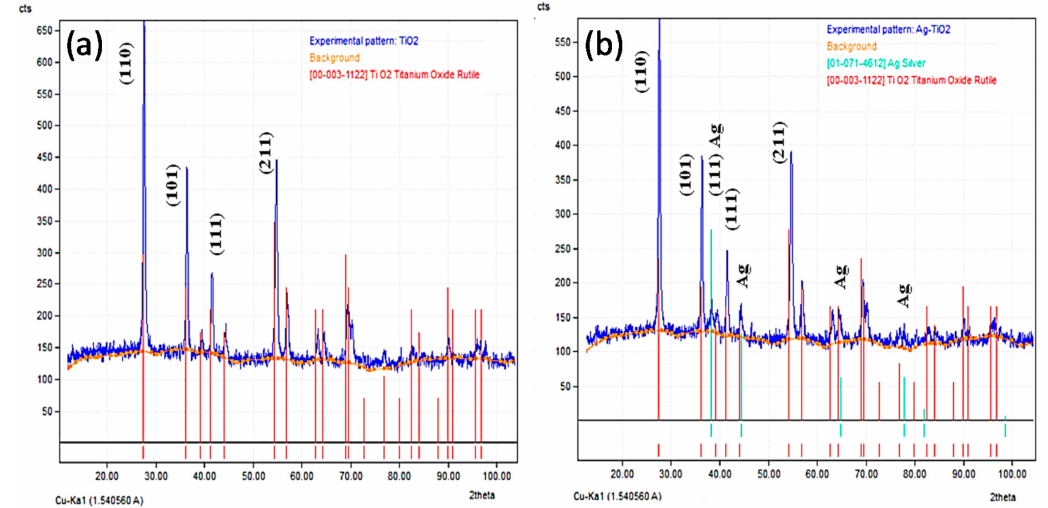
Figure 3. XRD patterns of ( a ) TiO 2 nanoparticles and ( b ) Ag / TiO 2